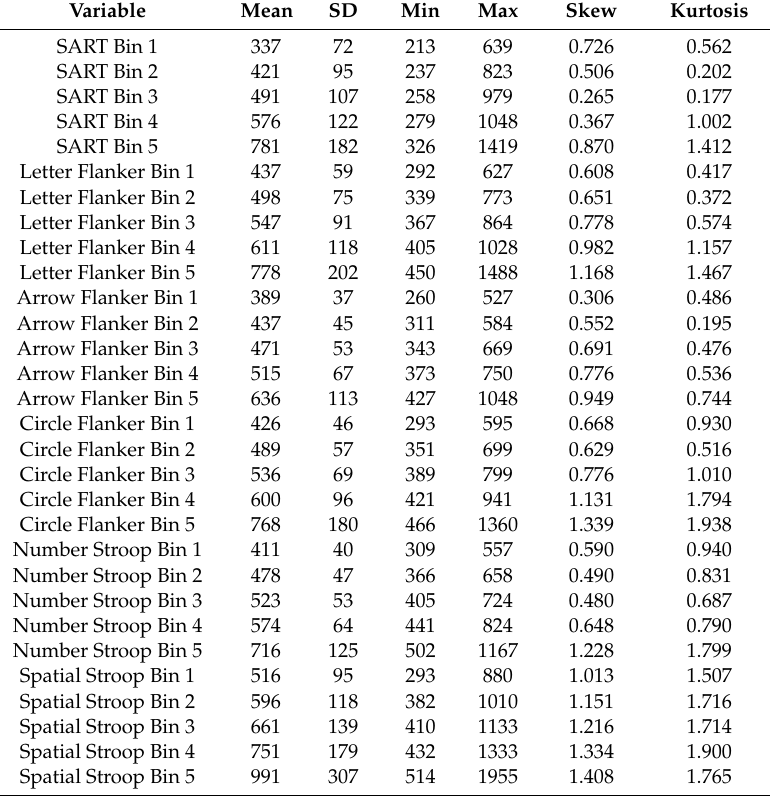
Table 1. Descriptive statistics for ranked-bin measures for each reaction time